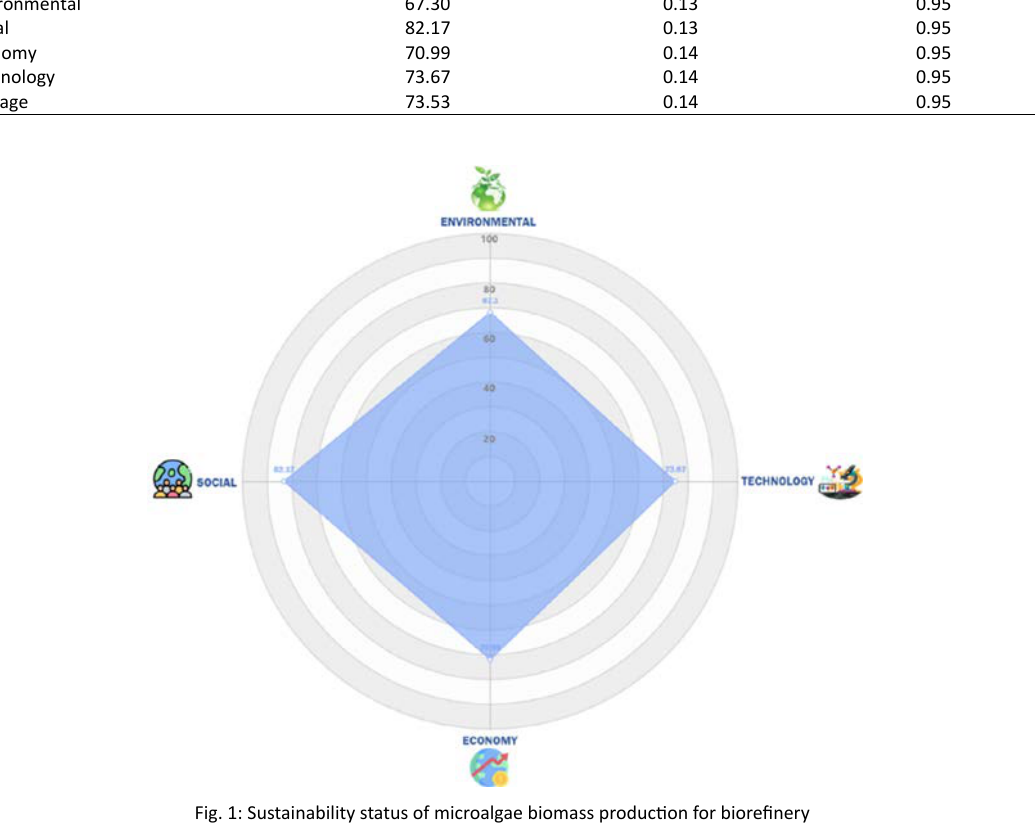
Table 4: Sustainability index results for environmental, social, economy and technology dimensions with data quality indices Dimension